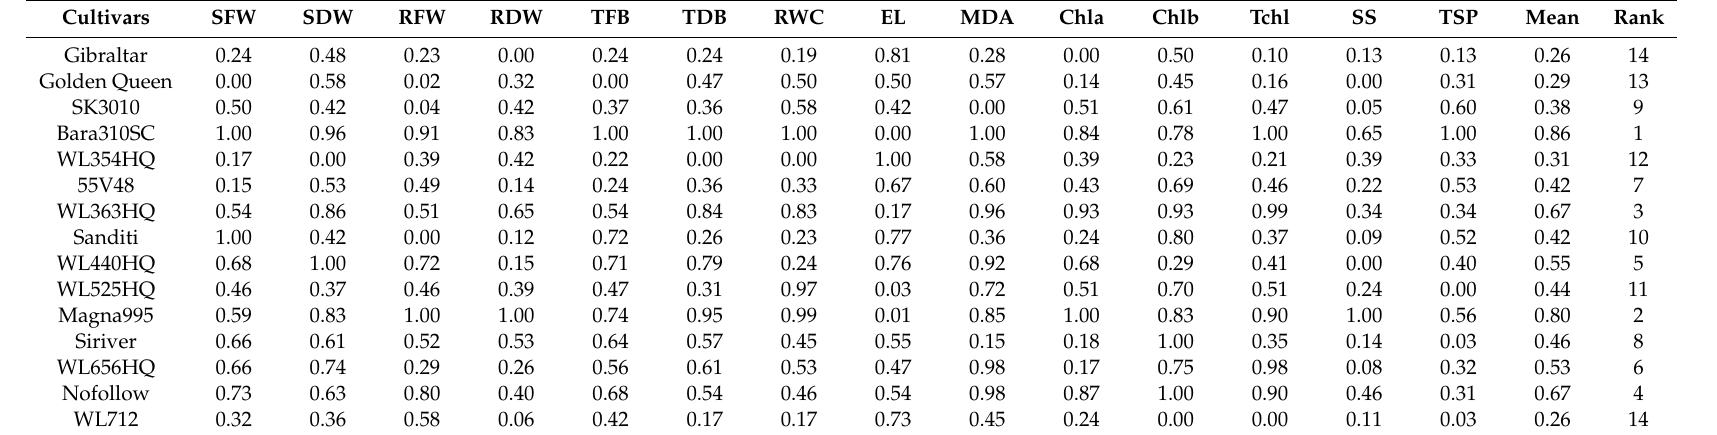
Table 5. Membership function value of alfalfa